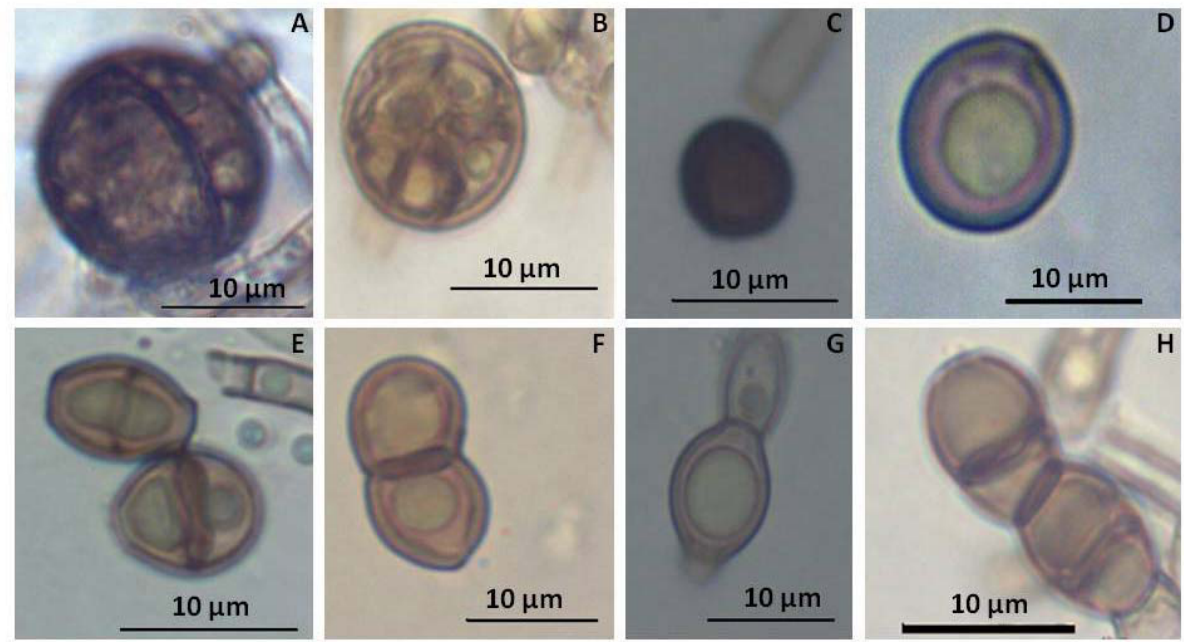
Figure 1. Highly melanized fungal forms with diameters ranging from 5 to 20 µm from pure cultures of F. pedrosoi cultivated for six months (1000x). ( A and B ) Multicellular and ( C and D ) unicellular chlamydoconidia; ( E - H ) roundish cells. * Many cells have an enlarged nucleus (light green).